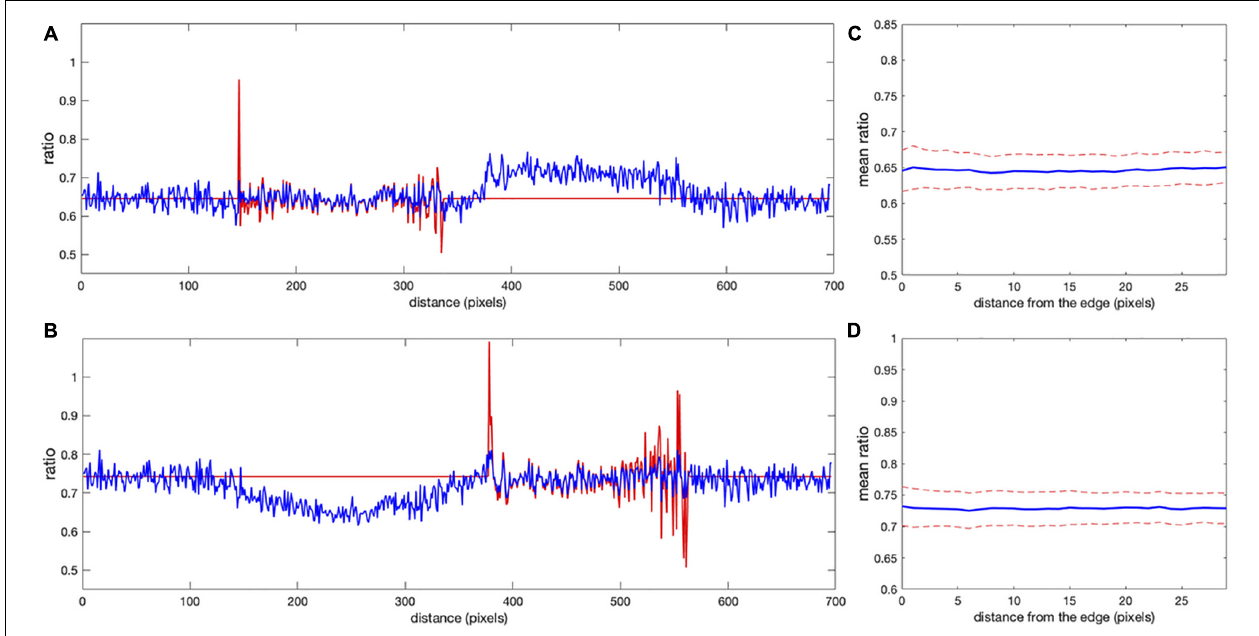
FIGURE 6 | Comparison of correction using the noise correction factor (NCF) versus mean background subtraction. (A,B) The ratio profiles from the images in Figures 5C,D along the line at the same location as in Figure 1 . Red and blue colors indicate the ratios obtained with the mean background subtraction and NCF methods, respectively. Both results overlap inside the cells away from the edge [left cell in panel (A) and right cell in panel (B) ]. Near the cell edges, the shape of the profile is still consistent between the methods, but the artifacts are not present in the result of the correction factor method. (C,D) Mean ratio signal as a function of the distance toward the cell center from the edge after applying the correction factor [panel (C) for the left cell and panel (D) for the right cell], showing the expected flat level with only 1.2 and 0.9% deviation from a perfectly constant line. The variance of the fluctuations is also flat all the way to the cell edge, in contrast to the background subtraction approaches (see Figures 3 , 4E